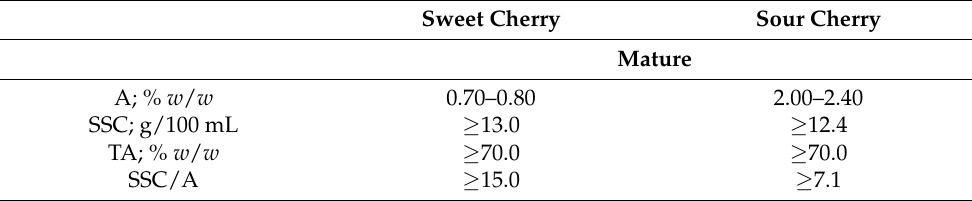
Table 6. Concentration ranges for immature—mature